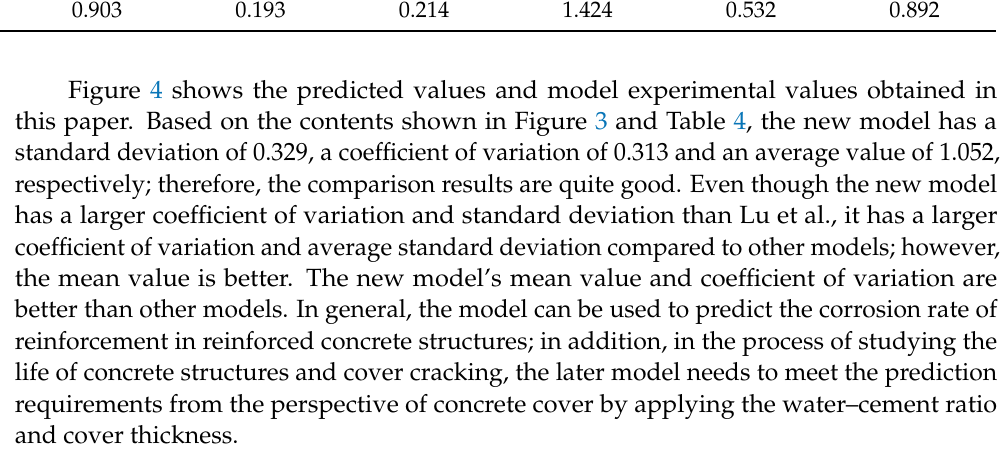
11 of 16 Table 4. Comparison of corrosion rate results of new prediction models based on experimental data. Data Sources Comparison of New Prediction Model Results Mean Value